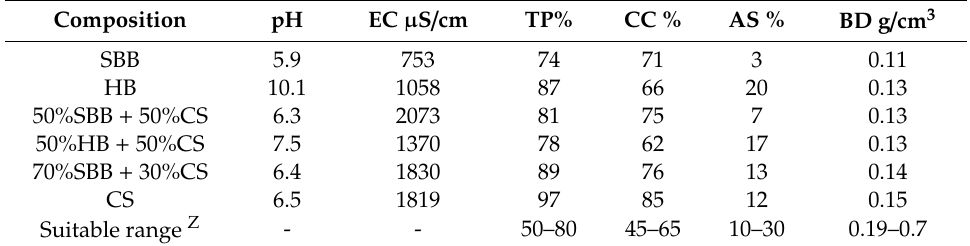
Table 1. The pH, electrical conductivity (EC), total porosity (TP), container capacity (CC), air space (AS), and bulk density (BD) of biochars and the substrate mixes used in this study. Composition pH EC µ S / cm TP% CC % AS % BD g / cm